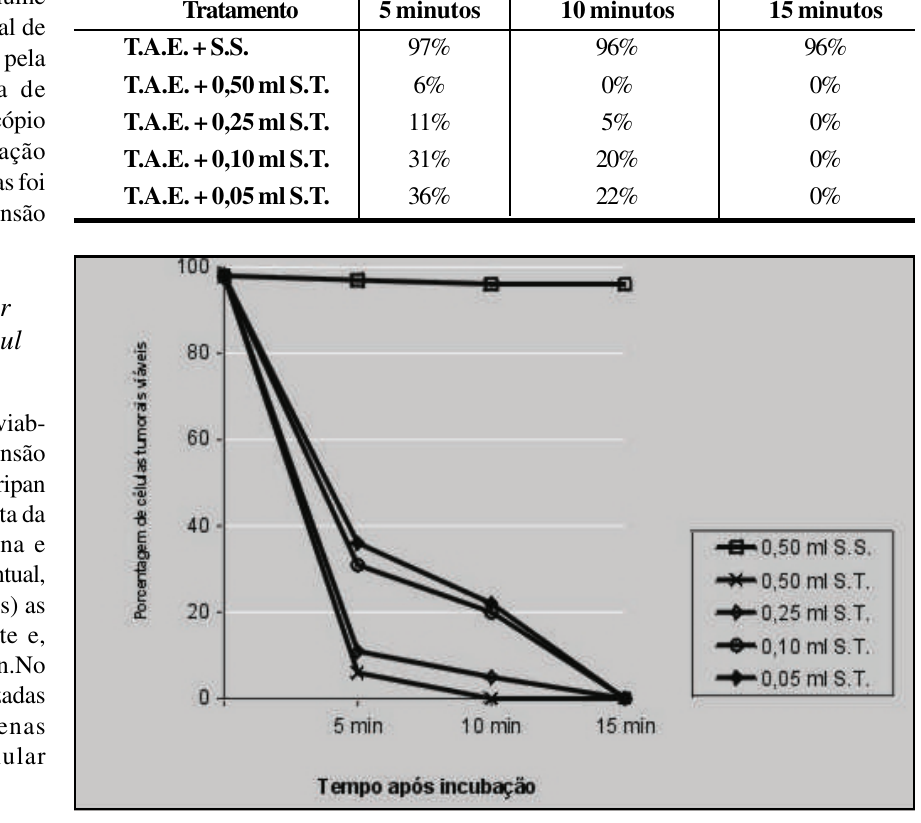
FIGURA 1 – Porcentagem média de células tumorais viáveis após 5, 10 e 15 minutos de incubação com S.S ou S.T. S.T. (0,50 ml) respectivamente: na Figura 2a nota-se que as células 5 e 10 minutos de incubação com S.S ou